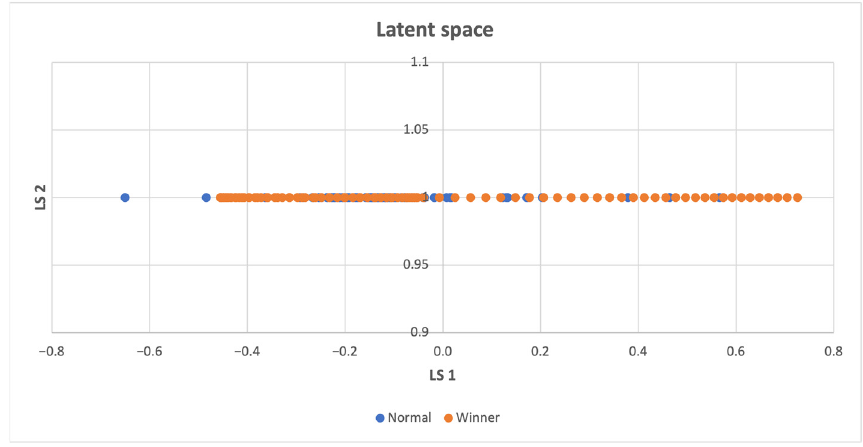
Figure 9. Latent space of the MountainCar-v0 environment, the winning and normal states have a significant overlap, indicating that the completion of the task is unlikely to require abrupt changes in parameters.